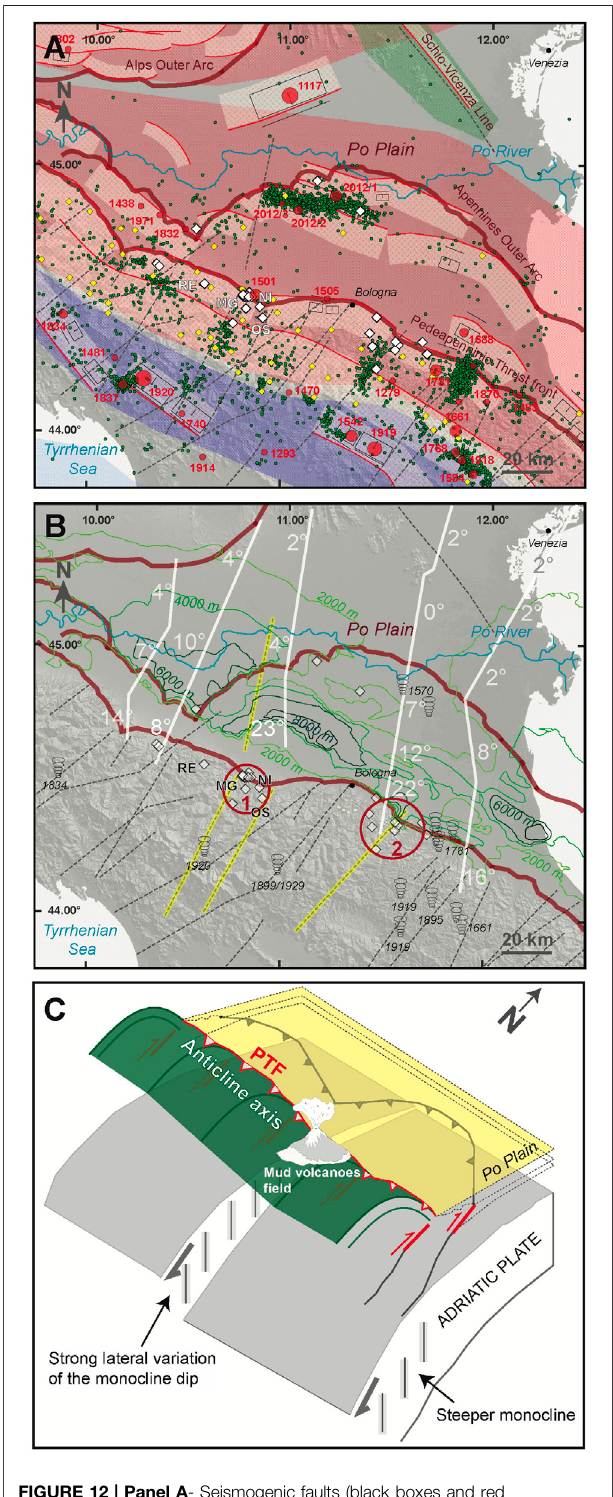
FIGURE 12 | shown by red symbols and labeled with the year of occurrence (from CPTI15). Background earthquakes (M w ≥ 2.5) that occurred in the intervalJanuary2000 – May2020areshownbygreendots(https://doi.org/10. 13127/ISIDE;ISIDEWorkingGroup,2007).Keytomudvolcanoes:NI:Nirano, MG: Montegibbio, OS: Ospitaletto, and RE: Regnano mud volcanoes fi elds. Panel B - Mud volcanoes (enclosed in a brown circle if mentioned in the text), transverse lineaments (highlighted in yellow if mentioned in the text), and main structural elements. The 3D spiral symbols locate gas emissions, mud cone eruptions and H 2 S emissions that were activated following the earthquakes whose year of occurrence is indicated in italics (from CFTI5Med). Sections of the northern Apennines foreland monocline are shown by white lines; numbers indicate its inferred dip (from Mariotti and Doglioni, 2000). The green lines are isopachs of the Pliocene-Pleistocene marine and continental de- FIGURE 12 | Panel A - Seismogenic faults (black boxes and red posits (from Bigi et al., 1992). Panel C - Sketch illustrating the structural ribbons), transverse lineaments (black dashed lines), main structural elements position of the mud volcanoes discussed in this work. The largest northern (brown lines; from Bigi et al., 1992), gas seeps (yellow diamonds) and mud Apennines mud volcanoes locate where the anticline axis of the Pedeapen- volcanoes (white diamonds) in the northern Apennines (see Figure 7 for ninic Thrust Front (PTF) intersects the surface manifestation of a lithospheric location).Activetectonicdomainsasin Figure2 .EarthquakesofM w ≥ 5.5are slab tear (see the CH 4 Emissions and Mud Volcanoes: Distribution and ( Continued ) CH 4 Emissions and Mud Volcanoes: Structural Control